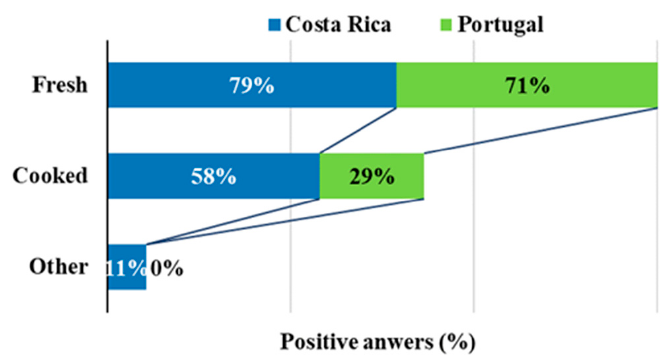
Figure 5. Forms of consumption of EF.